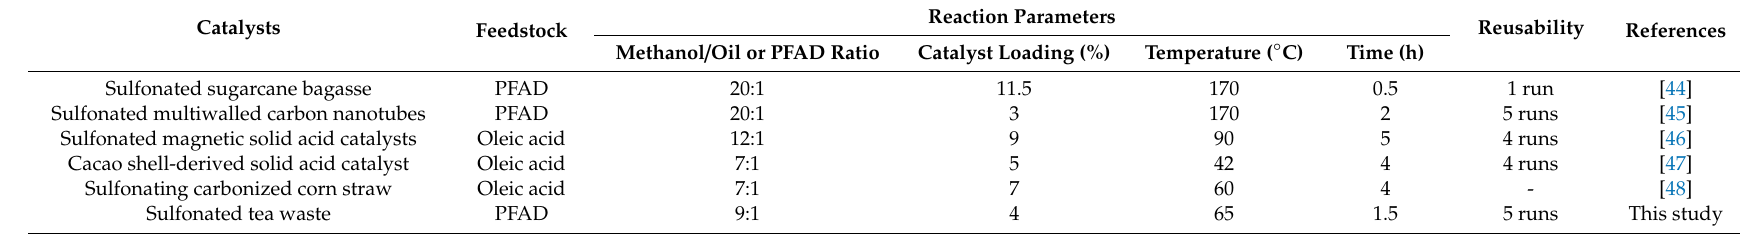
Table 3. Catalytic activity of di ff erent residues valorized as sulfonated char catalysts for